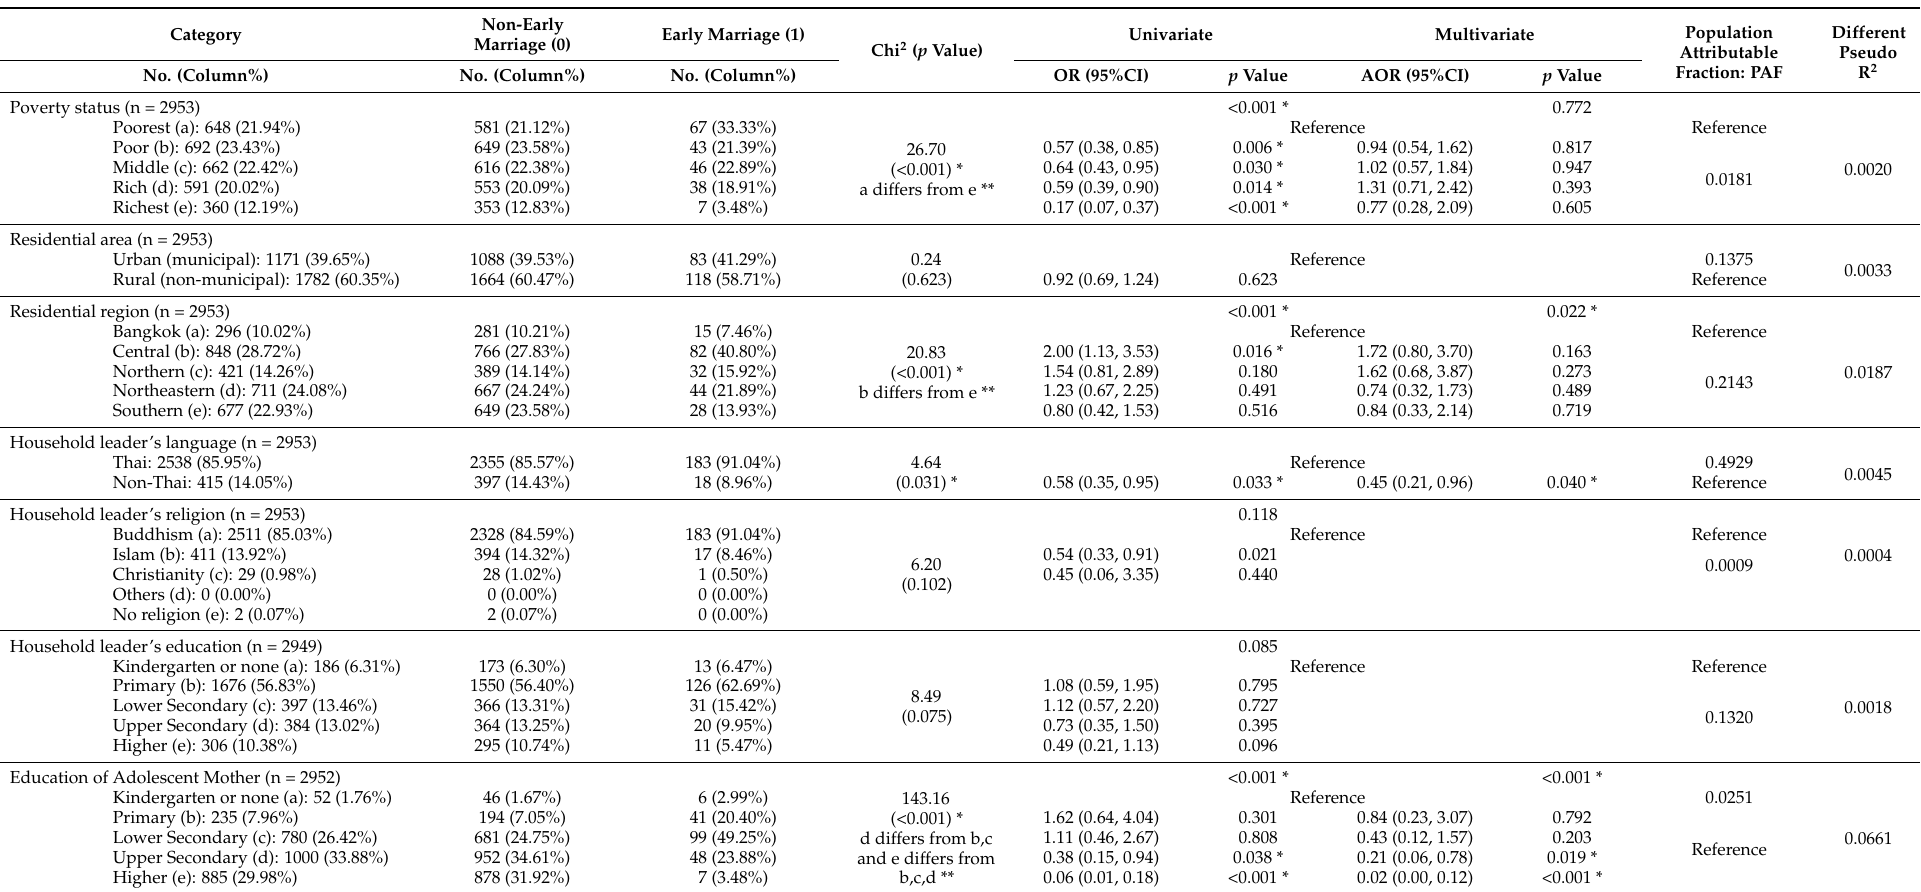
Table 5. The proportion of women aged 20–24 years who were married or in union before age 15 years by socioeconomic status (SES), association between early marriage and socioeconomic status, and effect of each SES as illustrated by the PAF and different pseudo-R-squared